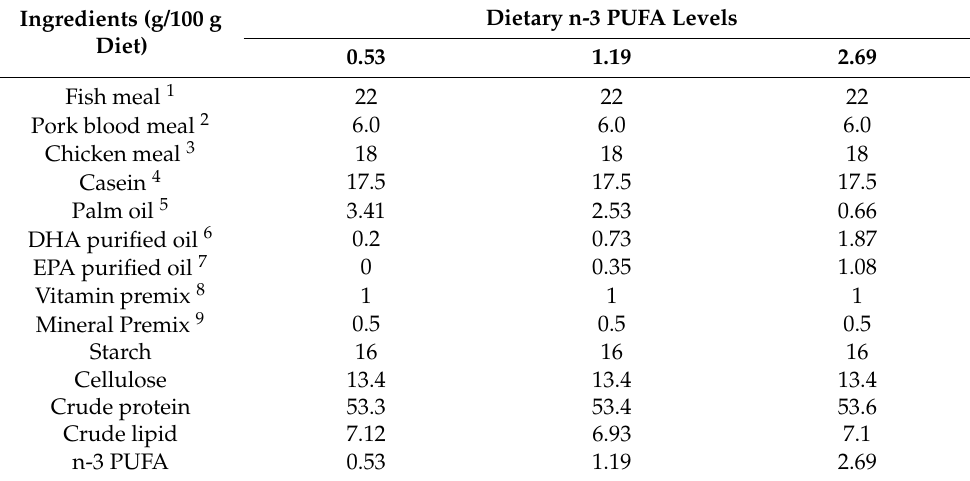
Table 2. Formulation and proximate analysis of the experimental diets.